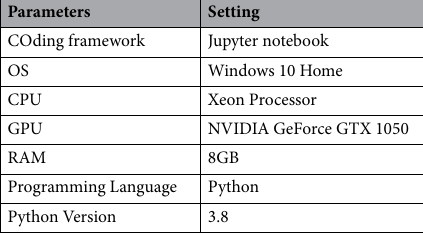
Table 1. Environment